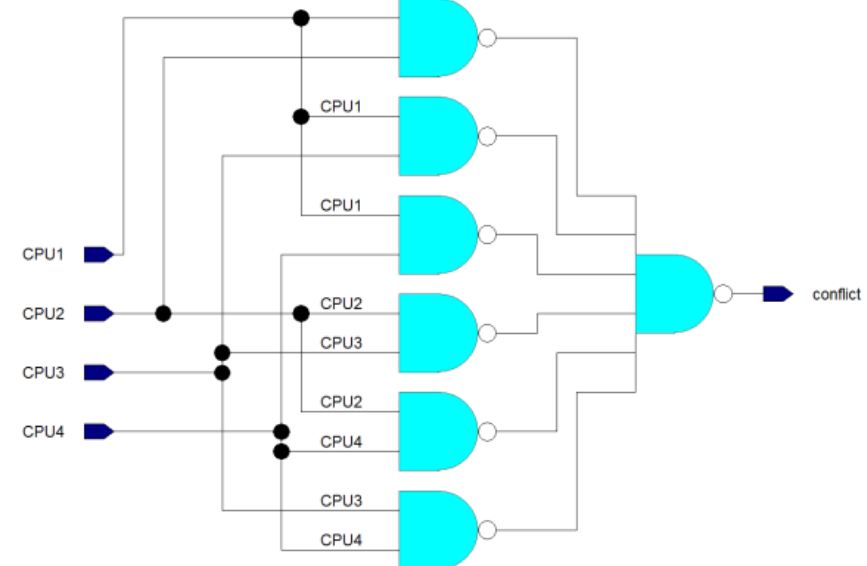
Figure 5. Logic circuit of Con fl ict Detector.